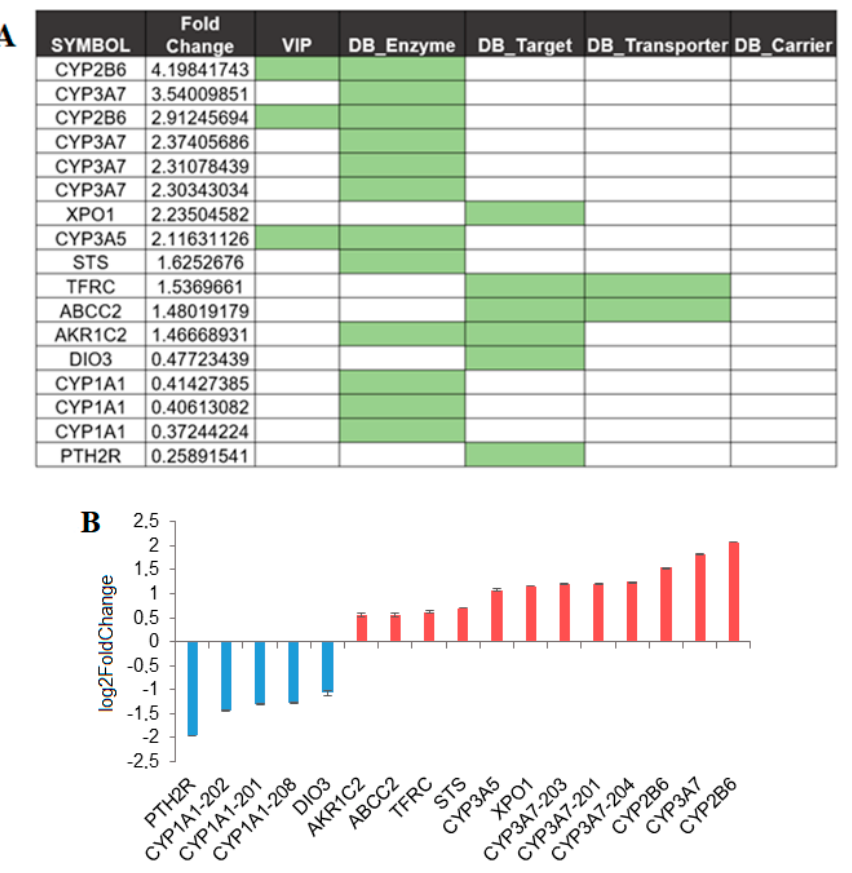
Figure 3. Sex affects gene expression in the liver. ( A ) SBDR transcript identified in liver, fold changes in female as compared to male are indicated. Transcripts that belong to one of the classes analyzed in this work, VIP and drug target, transporter, carrier, and enzymes are highlighted. ( B ) Transcripts showing differential abundance, which is at least 40% of up- or downregulation in females compared to males, were plotted.